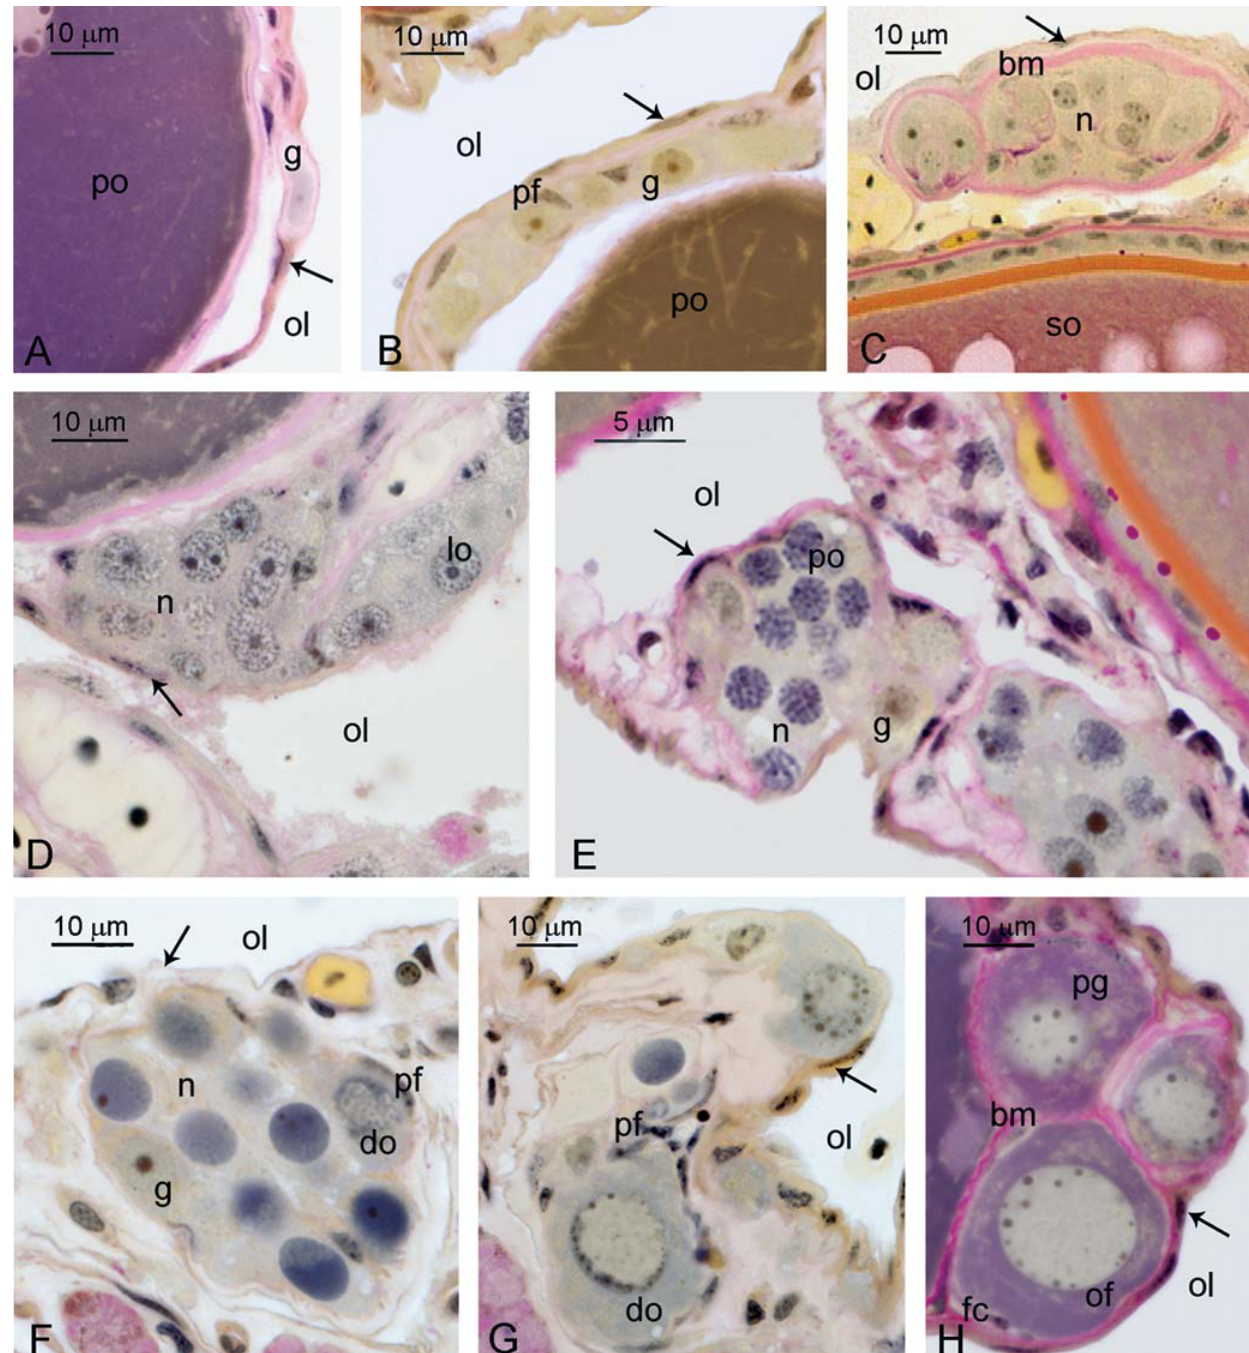
Fig. 1. Folliculogenesis in Gymnotus sylvius . Light Microscopy. A: Scattered in the germinal epithelium, the quiescent oogonium (g) is wrapped by the epithelial cells (arrow). Ovarian lumen: ol; Primary growth oocyte: po. B: Oogonia (g) proliferate and are surrounded by cells derived from the epithelium, the prefollicle cells (pf). Epithelium: arrow; Ovarian lumen: ol; Primary growth oocyte: po. C: Proliferation of the oogonium give rise to cell clusters, the germ cell nests (n), upon the magenta, PAS-positive basement membrane (bm) which in cross section is seen surrounding the nest. Epithelium: arrow; Ovarian lumen: ol; Secondary growth oocyte: so. D, E: In the nests (n), with the beginning and progress of meiosis, the prophase oocytes differentiate. In leptotene (lo) and in pachytene (po), they can be distinguished by the pattern of chromatin condensation. Proliferating oogonia (g) and prophase oocytes co-occur in a same nest (n). Epithelium: arrow; Ovarian lumen: ol. F, G: Prefollicle cells increasingly surround the oocytes, separating them one from another. As basement membranes form around individual oocytes and the prefollicle cells surrounding them, they are separated from the cell cluster. Completely surrounded by and individualized